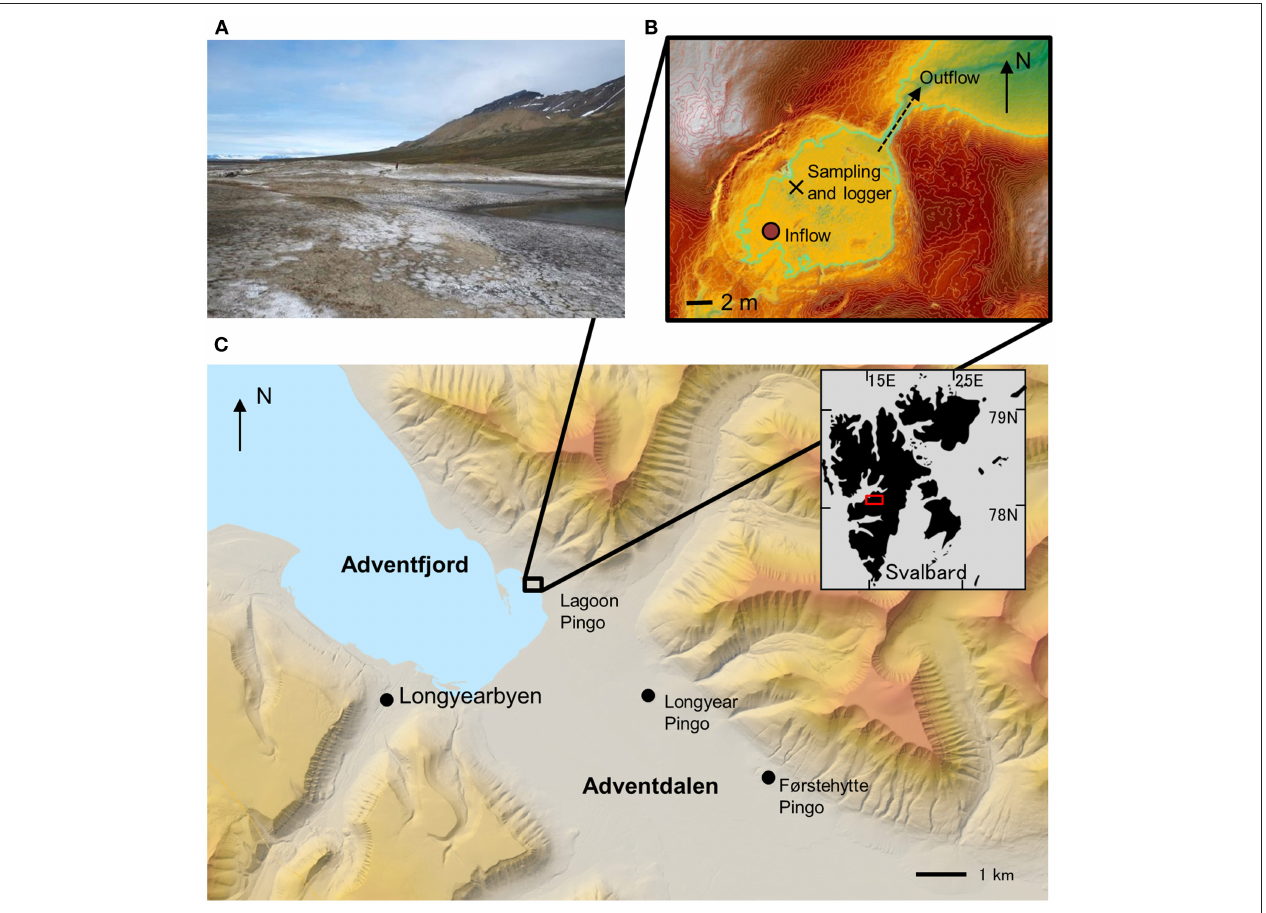
FIGURE 1 | Field Site description. (A) Photograph looking west showing efflorescent salts on surface of uplifted pingo. Note person for scale. (B) Aerial view of pingo pond monitoring site showing principal outflow to northeast, the upwelling inflow, the sampling and instrumentation sites and (green line) the pond level in October. Contours are at 10cm intervals. (C) Local setting of the pingo in Adventdalen, showing two more open system pingos in the valley